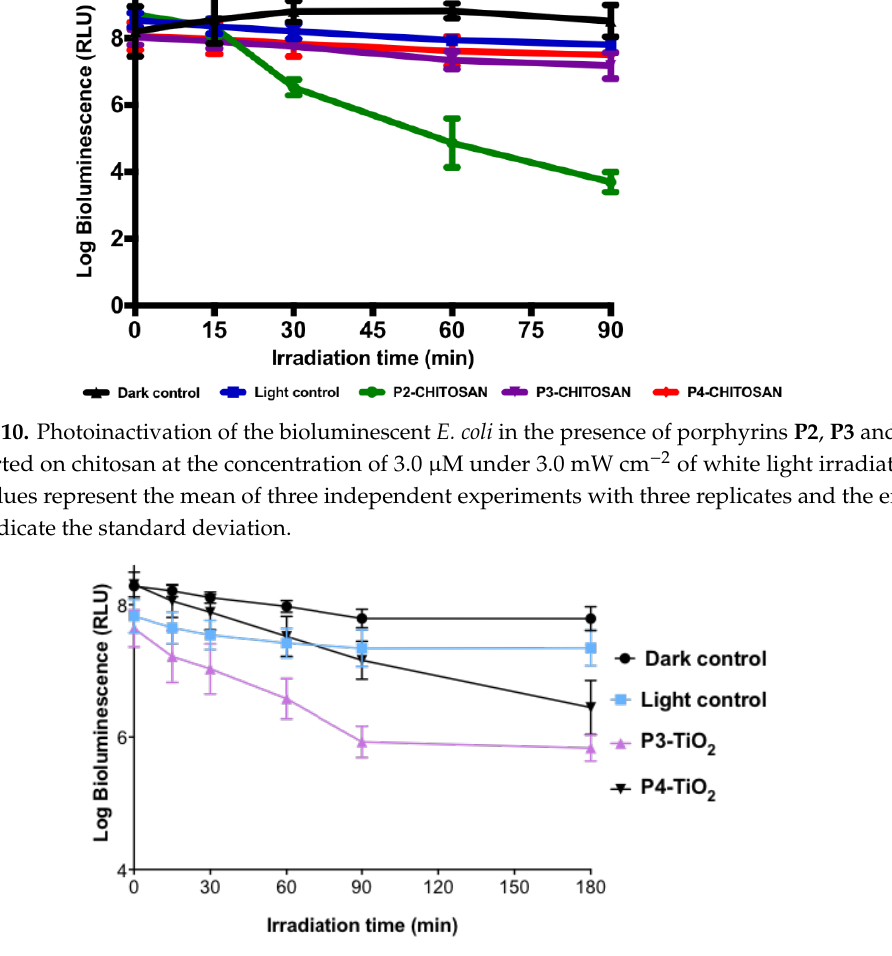
Figure 11. Photoinactivation of bioluminescent E. coli with 10 µ M of the porphyrins P3 and P4 supported on TiO 2 under 3.0 mW · cm − 2 of white light irradiation. The values represent the mean of three independent experiments with three replicates and the error bars indicate the standard deviation.